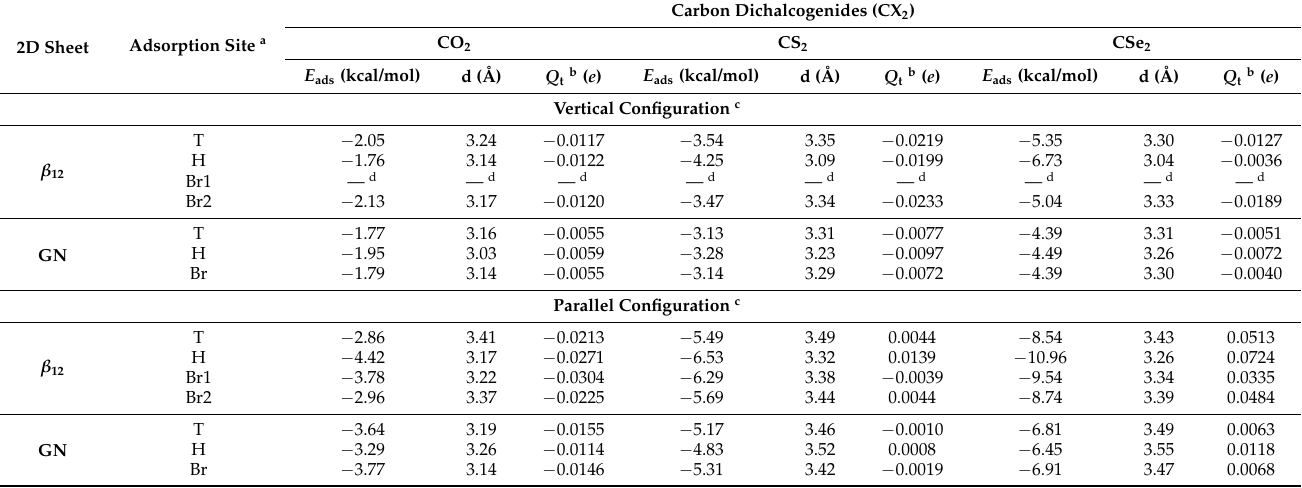
Table 1. Adsorption energies ( E ads , kcal/mol) and equilibrium distances (d, Å) for the vertical and